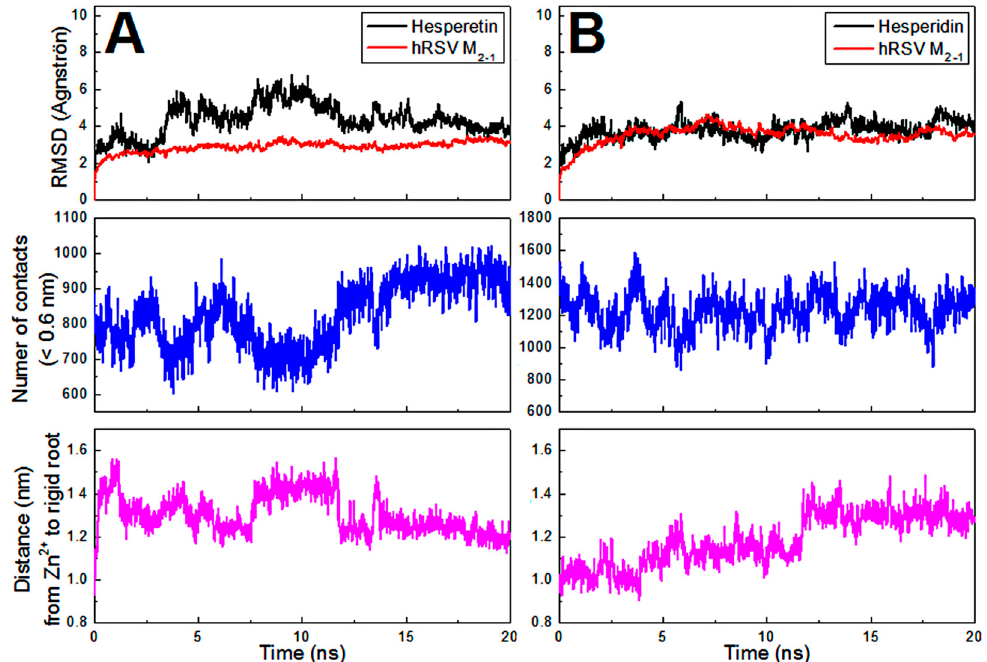
Figure 5. Analysis of the parameters from 20 ns molecular dynamics simulations of the structural models of the complexes formed with the HST ( A ) and HSD ( B ) determined by AutoDock program. On the top, the root mean square deviations (RMSDs) of non-hydrogen atoms of the flavonoids (black line) and backbone atoms of the M 2-1 protein (red line) from the starting structure (AutoDock model) for the complexes are reported as a function of time. In the middle, number of contacts between atoms of the M 2-1 and flavanones for distances < 0.6 nm. At the bottom, distance from Zn 2 + atom in the zinc-finger domain of the protein to the rigid root of the flavanones. As molecular dynamics simulations were performed in duplicate, the mentioned parameters were presented as average.